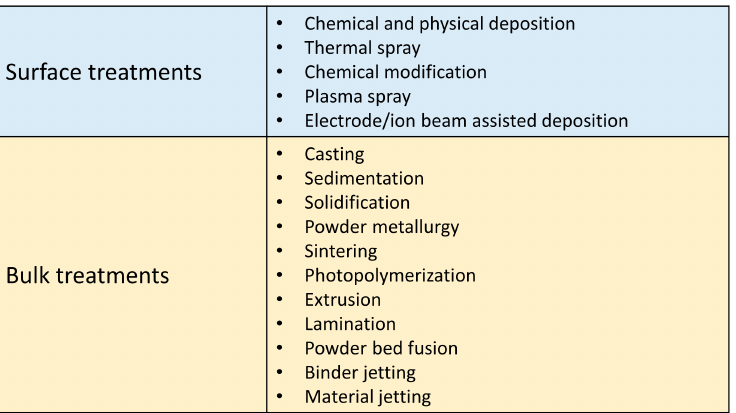
Figure 5. Examples of technologies for functionally graded materials (FGMs)